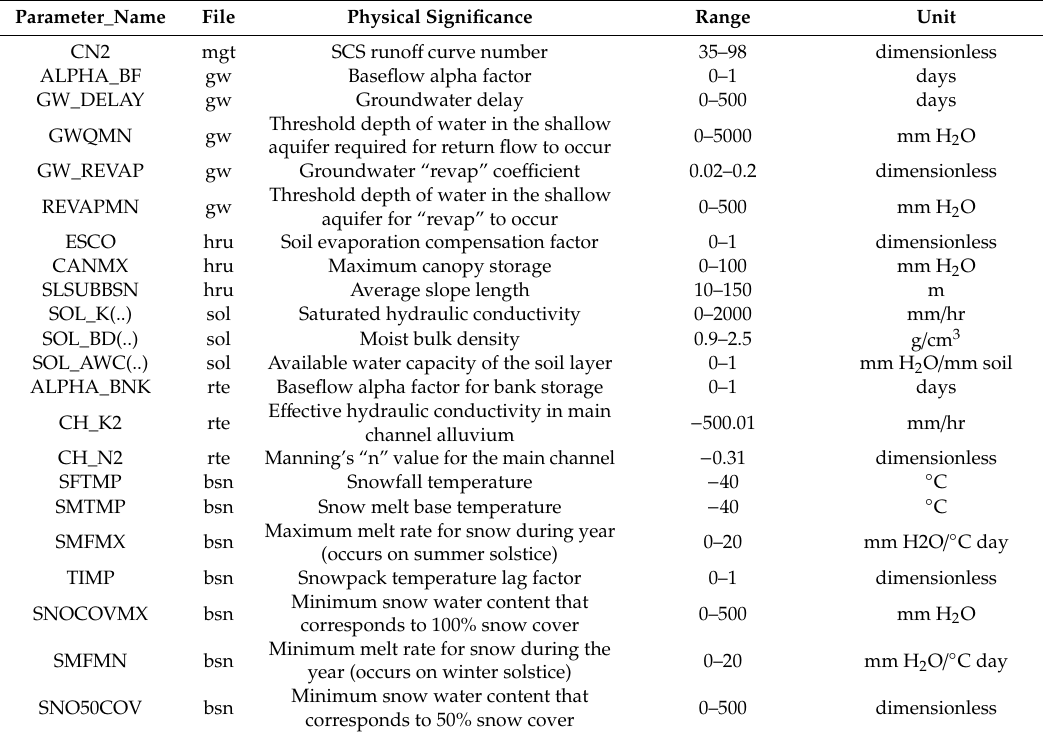
Table 3. Physical meaning and range of relevant